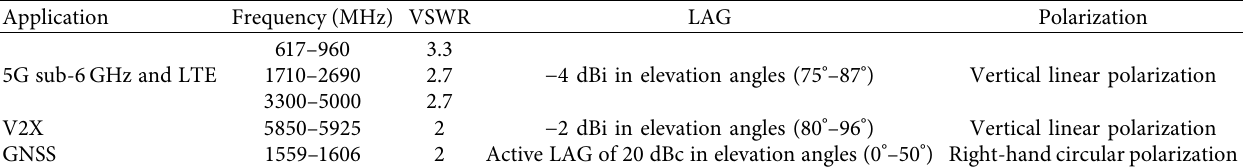
Table 2: Antenna performance